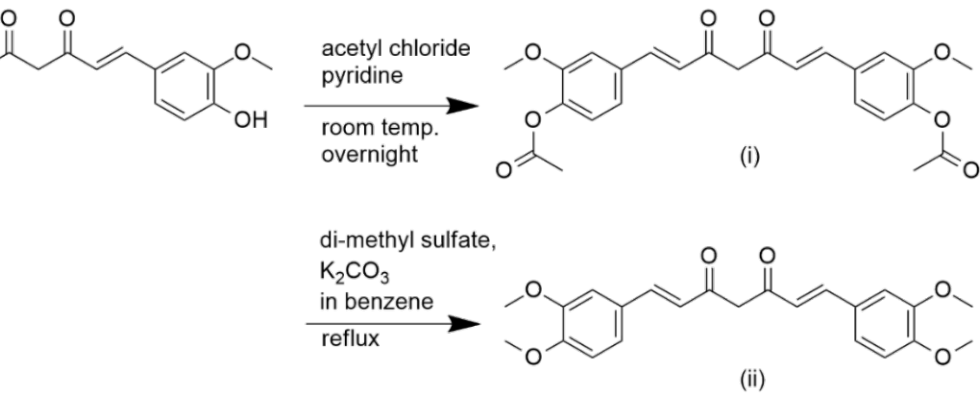
Figure 5. The reaction scheme for the synthesis of di-O-acetyl and di-methoxycurcumin involving substitution of the phenolic OH group [37].